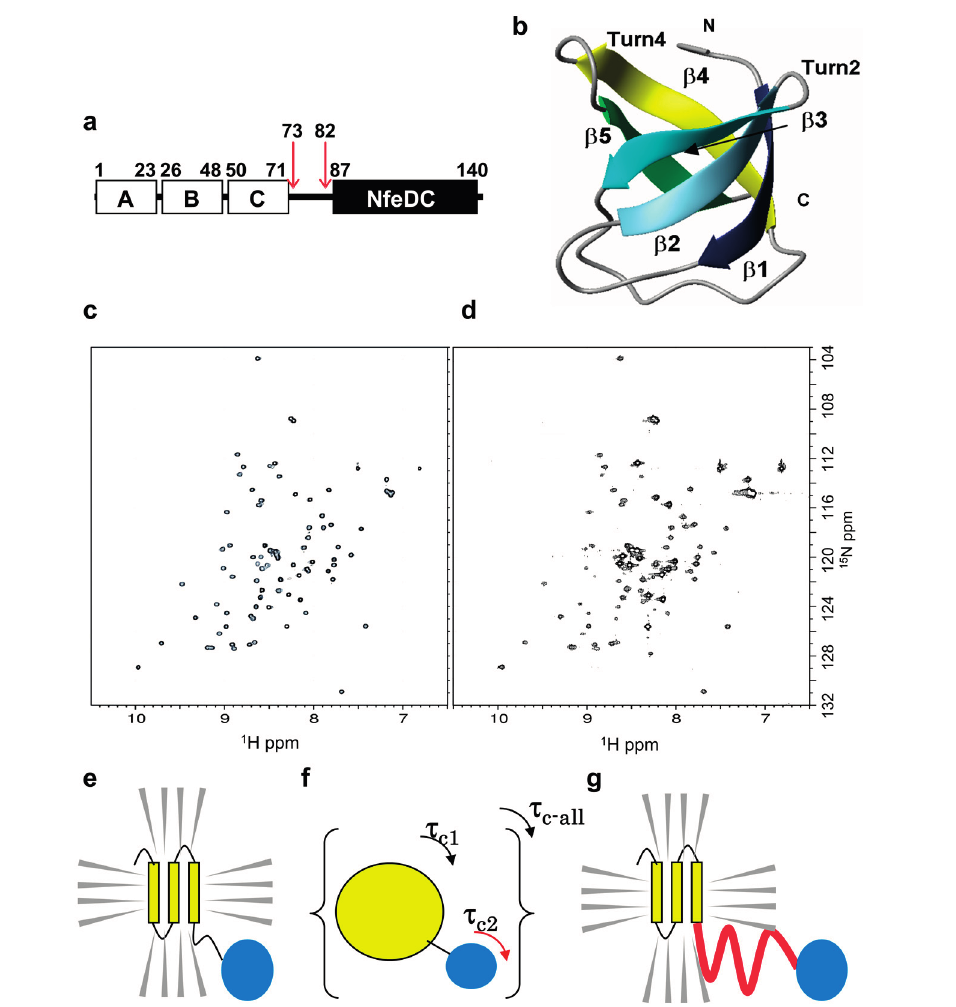
Figure 1. The concept and background for evaluating intrinsically disordered proteins (IDPs) using the PH0471 chimeric membrane protein-based nuclear magnetic resonance (NMR) experiment. ( a ) The domain architecture of Pyrococcus horikoshii PH0471 engineered with a C-terminal hexahistidine tag; ( b ) A ribbon representation of NfeDC PH0471 (PDB ID: 2exd); ( c ) The 2D 1 H- 15 N HSQC spectrum of the isolated NfeDC PH0471 (NfeDC domain-only construct of PH0471); ( d ) The 2D 1 H- 15 N HSQC spectrum of detergent solubilized full-length PH0471; ( e , f ) Schematics of the PH0471-based system relating to the partial ( τ c1 and τ c2 ) and overall ( τ c-all ) molecular motion (rotational correlation time) of a two-domain system connected by a flexible linker. If the linker is rigid, the two partial τ c s become equal to the overall τ c ( τ c1 ≈ τ c2 ≈ τ c-all ). The gray wedges and the yellow cylinders represent detergent molecules and the transmembrane helices A–C of PH0471, respectively; and ( g ) The chimeric membrane protein containing the IDP used in this study. The region indicated by a bold red line is replaced by various potential target